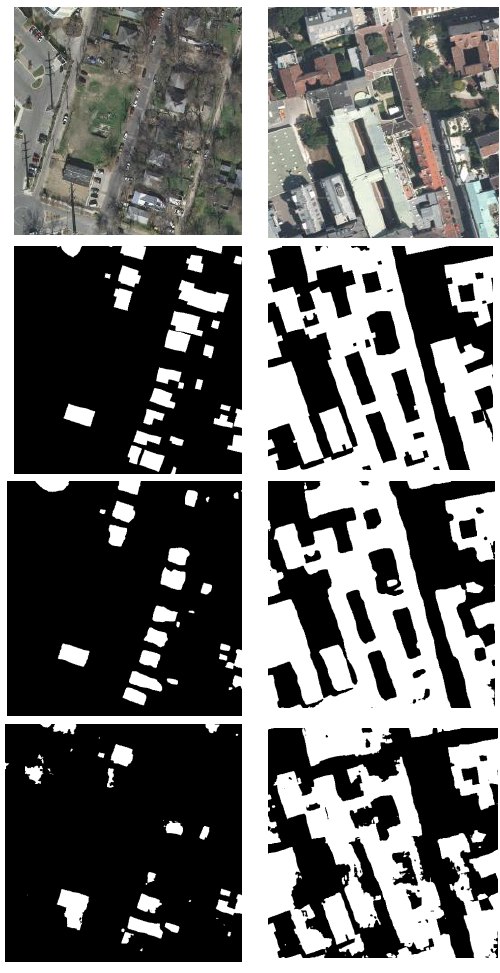
Figure 8. From top to bottom: the aerial images (first row), related masks (second row), and predicted masks in Inception ResNet UNet (third row) and UNet (last row).